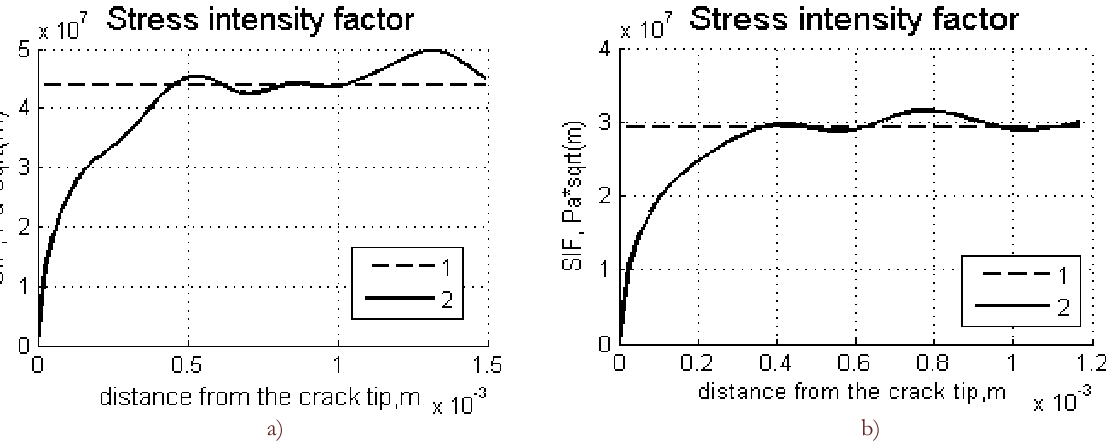
Figure 9: The dependence of SIF versus a distance from the crack tip in the direction of crack propagation. Loading frequency is 5 Hz (a), loading frequency - 10 Hz